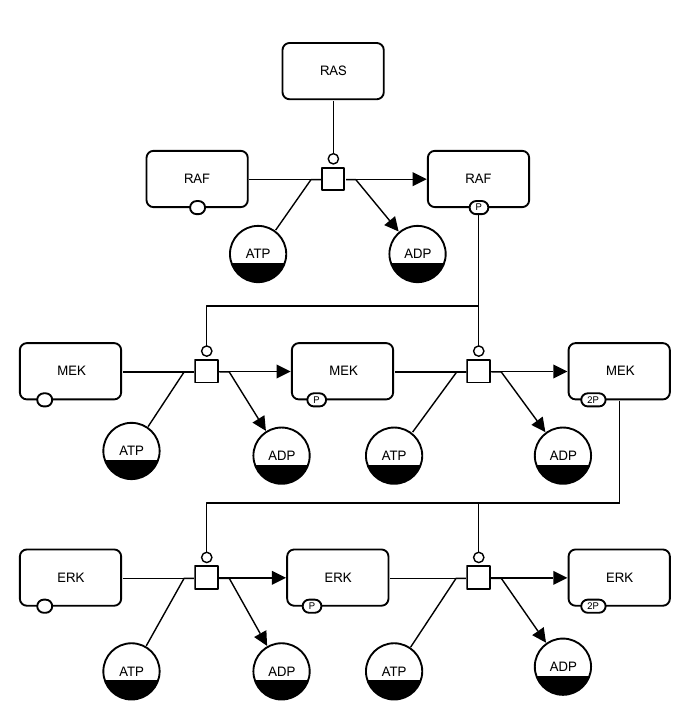
Figure A.3: A submap of the previous map showing the MAPK